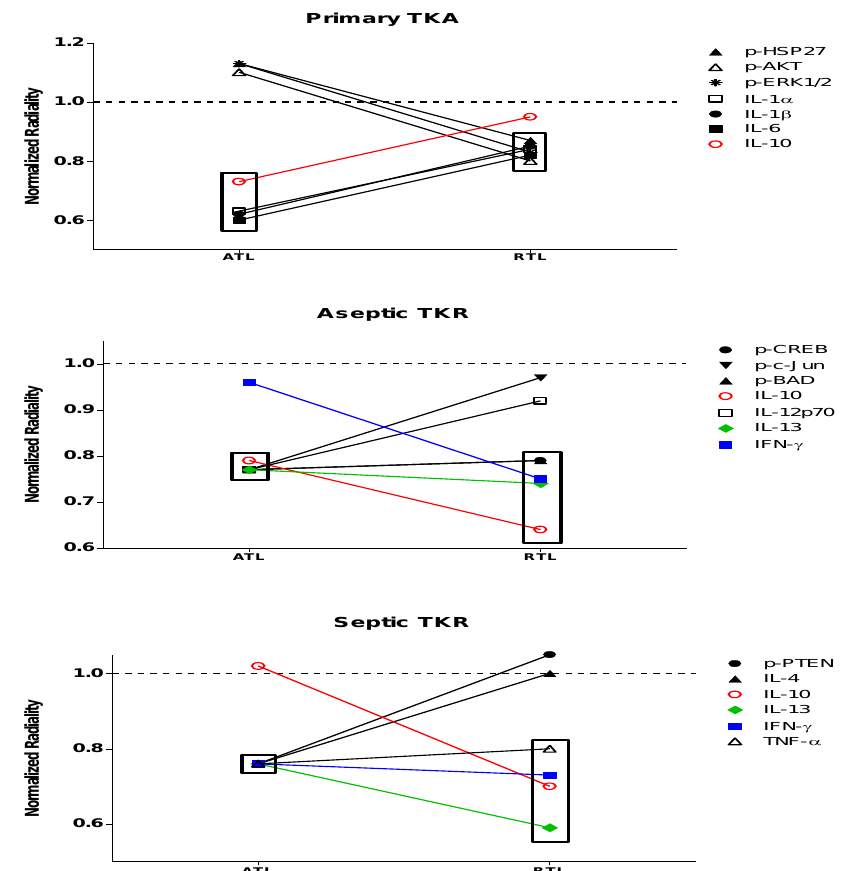
Figure 7. Changes in significant nodes between groups for low radiality outcomes. Nodes with low radiality outcomes that differed between primary TKA response and aseptic/septic TKR responses are shown (significance threshold: the average radiality ± standard deviation). Boxes indicate significance at varying depths. IL-10 is shown in red to highlight its presence in all three groups: primary TKA, aseptic TKR, and septic TKR. IL-13 (green) and IFN-γ (blue) are also colored to highlight overlap in both aseptic TKR and septic TKR groups.